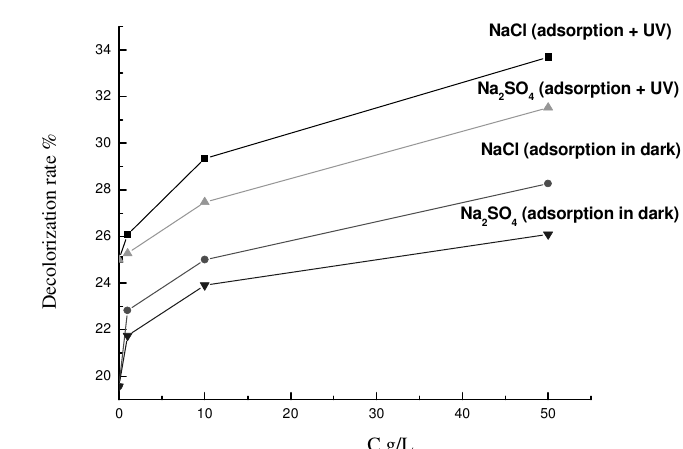
Figure 3. Influence of ionic strength on decolorization rate of EG loaded with